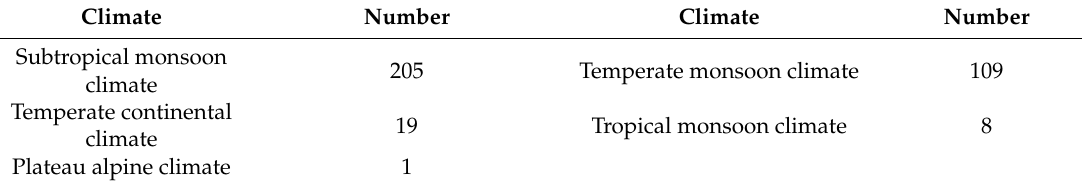
Table 3. Distribution of marathon running in di ff erent climatic area and air quality levels.